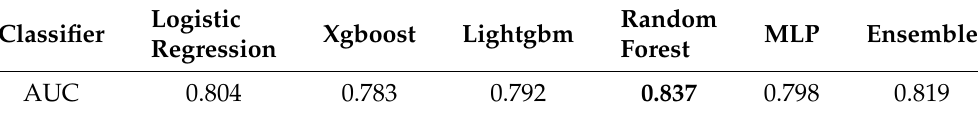
Table 4. Comparison of pCR prediction performance of various classifiers built on multi-parametric MRI embedding.